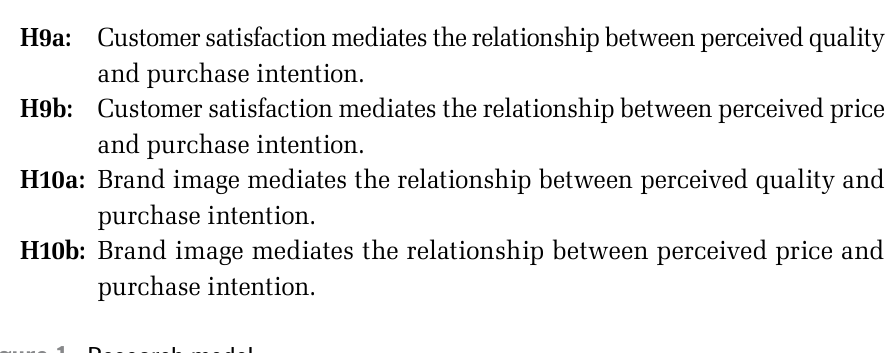
Figure 1. Research